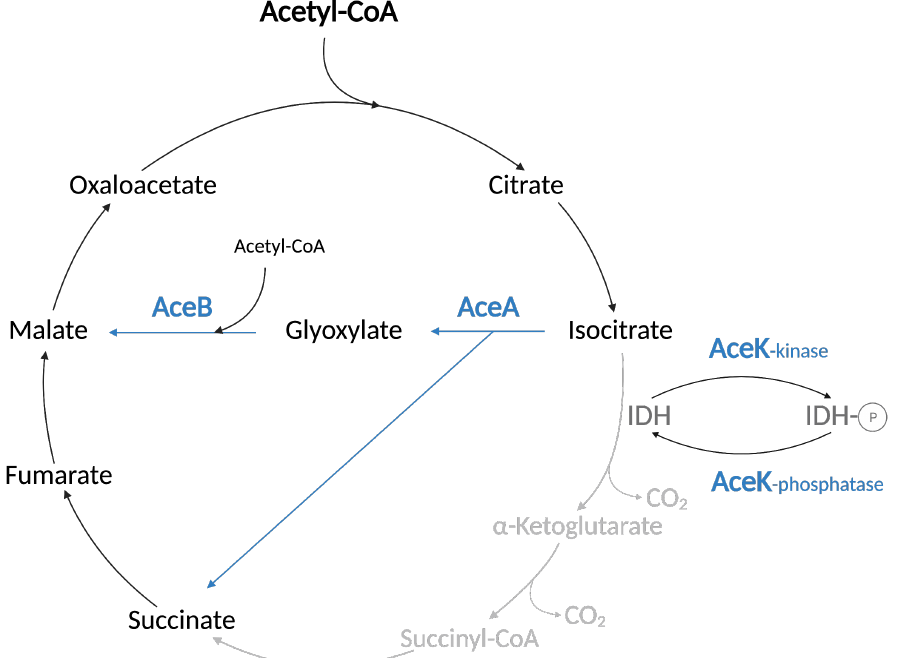
Figure 8. The glyoxylate shunt and related reactions. Acetyl-CoA enters in the tri-carboxylic acid (TCA) cycle. The isocitrate lyase AceA and the malate synthase AceB allow the conversion of isocitrate to malate and succinate by preventing loss of carbons in the form of CO 2 . The two reactions of the TCA cycle bypassed in the glyoxylate shunt are in gray. The regulation of the glyoxylate shunt by the AceK-dependent phosphorylation of the isocitrate dehydrogenase IDH is shown on the right. The IDH enzyme is shown in dark gray. All the intermediates of the cycle are in black. The enzymes involved in the glyoxylate bypass (AceABK) are in blue, as well as the arrows indicating the reactions carried out by AceA and AceB.